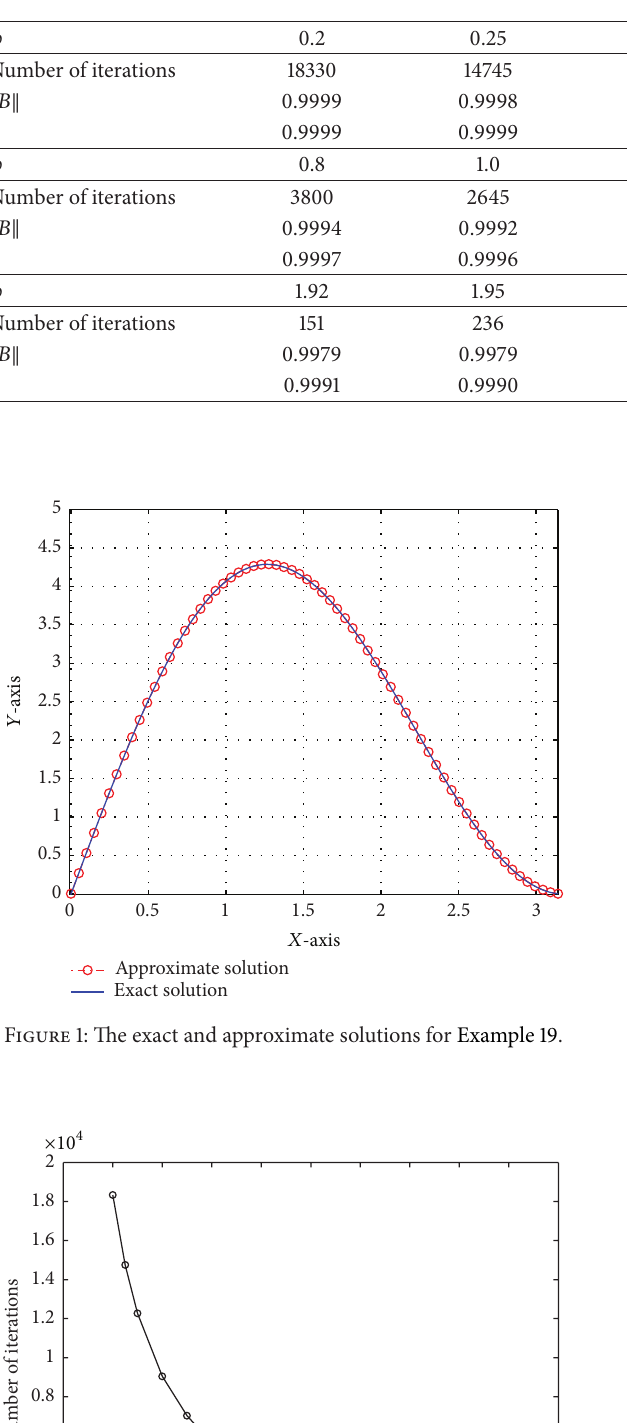
Table 1: Numbers of iterations and 𝜂 values for Example 19.